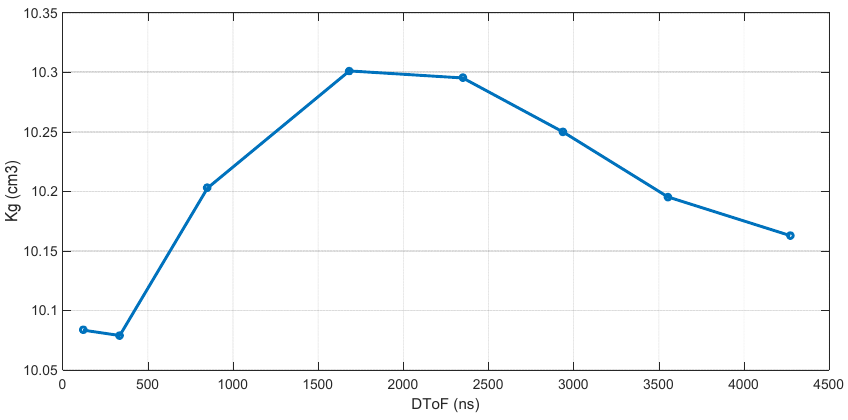
Figure 13. Piecewise linear calibration.